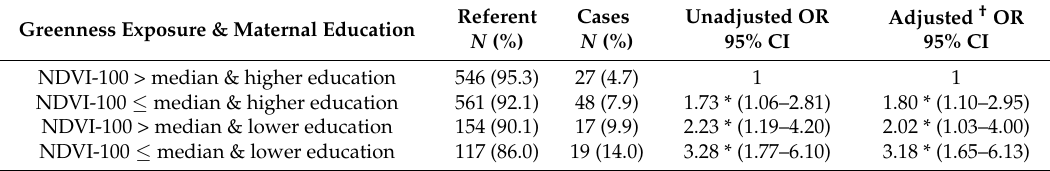
Table 4. Association between residential greenness level (NDVI-100 m radius), maternal education, and children’s overweight/obesity (stratified